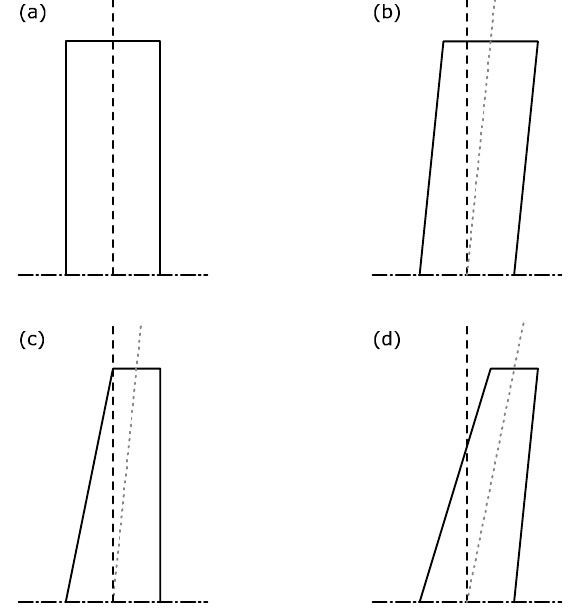
Figure 12. The four planforms examined in the swept foil performance comparison. ( a ) CR = 1, θ o , ( b ) CR = 1, θ o , ( c ) CR = 0.5, θ o , ( d ) CR = 0.5, θ o s = 0 s = 15 s = 0 s = 15